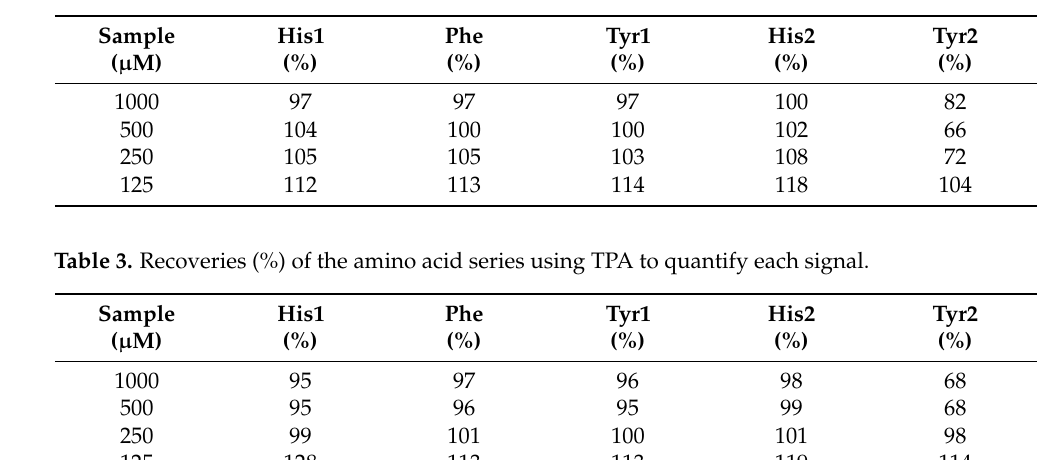
Figure 6. Aromatic proton regions of technical 1 H-qNMR spectra triplicates (overlays) of amino acid standard samples at 1 mM in deuterated phosphate buffer (100 mM, pH 12); 500 MHz spectrometer frequency, ns = 128, d1 = 30 s, 30 ◦ observation pulse, and no apodization. Table 2. Recoveries (%) of the amino acid series using SIPA to quantify each signal.